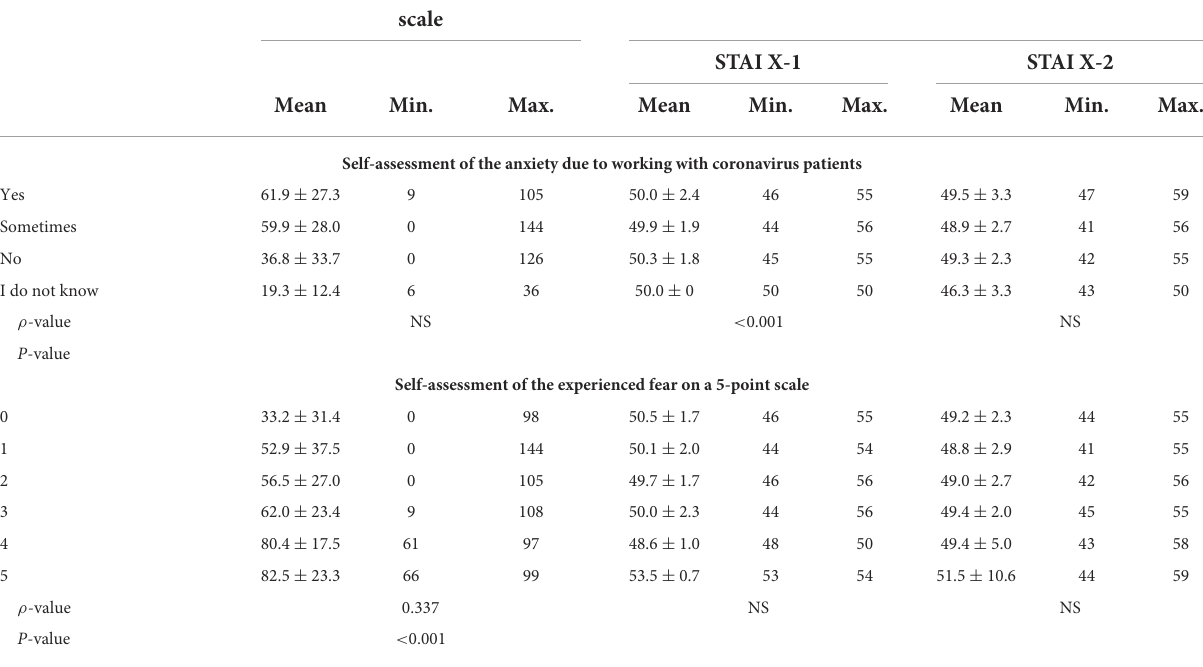
TABLE 3 Level of social anxiety and intensity of state anxiety (X-1) and trait anxiety (X-2) according to self-perceived anxiety due to starting work with coronavirus patients. Liebowitz social